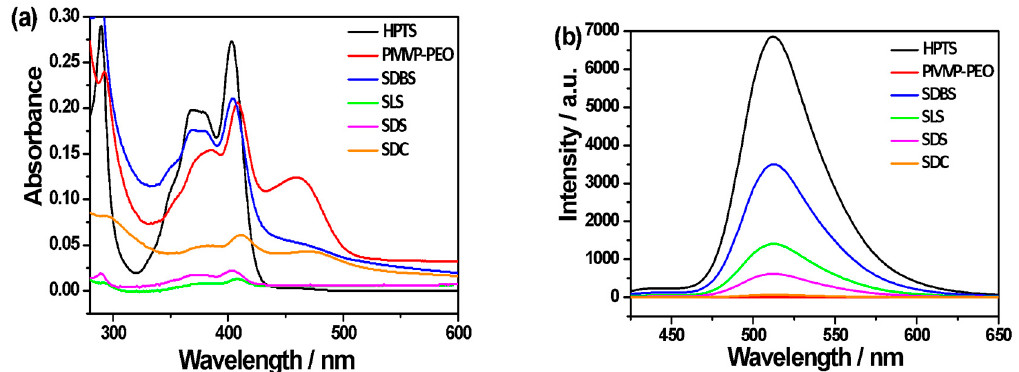
Figure 5. Absorption ( a ) and emission ( b ) spectra of the HPTS/PMVP 41 - b -PEO 205 complex in water in the presence of different anionic surfactants. [PMVP-PEO] = 0.4 mM; [HPTS] = 0.05 mM; [SDBS] = [SLS] = [SDS] = [SDC] = 0.2 mM. PMVP-PEO is the abbreviation of PMVP 41 - b -PEO 205 .